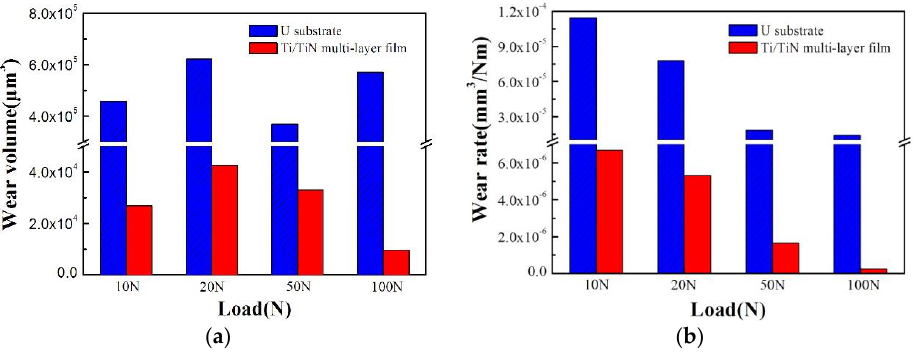
Figure 10. Wear volume and wear rate of uranium and the Ti/TiN film at different normal loads. ( a ) wear volume, ( b )wear